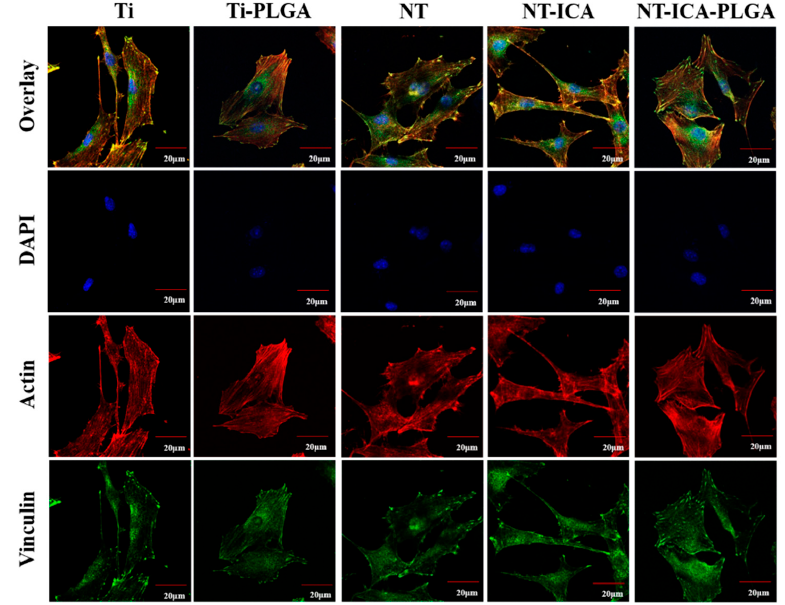
Figure 6. Confocal laser scanning microscopy (CLSM) images of MC3T3-E1 cells cultured on the different surfaces after 24 h of incubation. Images of cells stained with DAPI to show nuclei (blue), rhodamine-phalloidin to show actin cytoskeleton (red) and immunofluorescence for vinculin (green). Scale bar, 20 μ m. Abbreviations: CLSM, confocal laser scanning microscopy; DAPI, 4 ′ , 6-diamidino- 2-phenylindole. Three separate substrates were used for each group. The most representative images of three independent experiments were displayed.